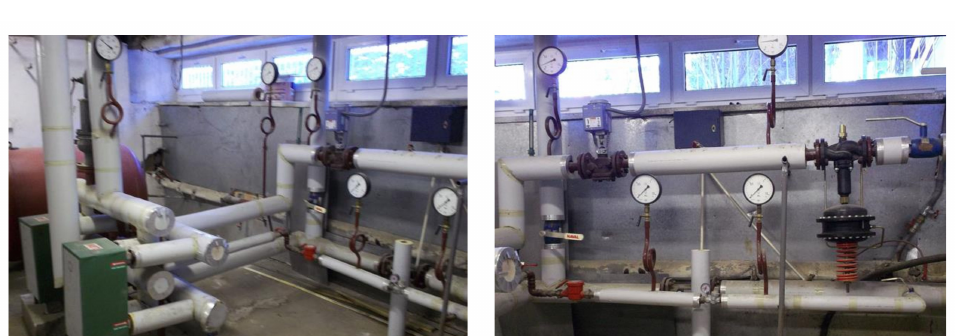
Figure 6. Technical condition of the W1 thermal substation and technological devices before modern- ization [photo authors].